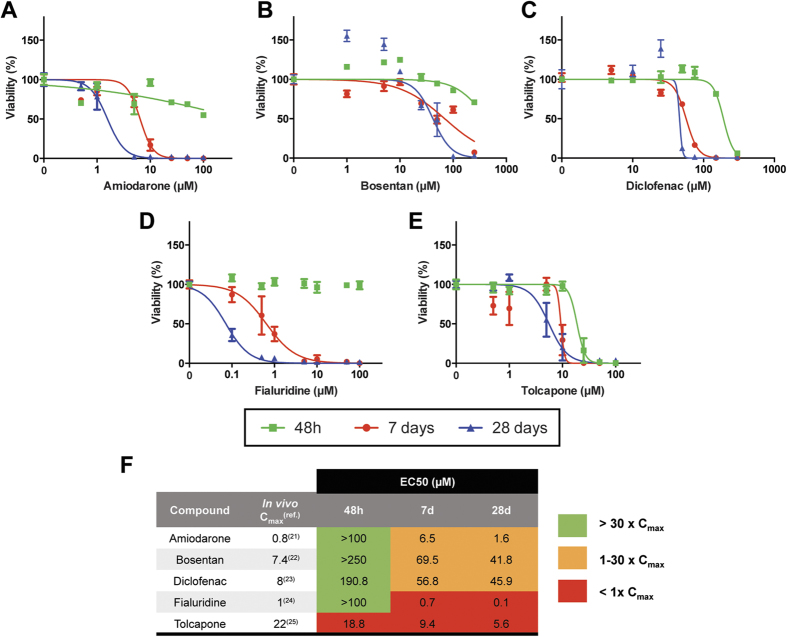
PHH spheroids support chronic toxicity assays.PHH spheroids were treated with amiodarone (A) bosentan (B) diclofenac (C) fialuridine (D) or tolcapone (E) every second day and viability was determined at 48 h, 8 days and 28 days by measuring cellular ATP content (n = 5–6 spheroids per concentration and time point). (F) Notably, EC50 values for all compounds decreased following long-term treatment (Fold changes in EC50 vs. 48 h: for amiodarone: 15.4-fold (8 d) and 62.5-fold (28 d); for bosentan: 3.6-fold (8 d) and 6.0-fold (28 d); for diclofenac: 3.4-fold (8 d) and 4.2-fold (28 d); for fialuridine: 142.9-fold (8 d) and 1000-fold (28 d); for tolcapone: 2-fold (8 d) and 3.4-fold (28 d)). Safety margins were calculated in order to relate the observed EC50 values to the physiological plasma Cmax values observed in vivo.